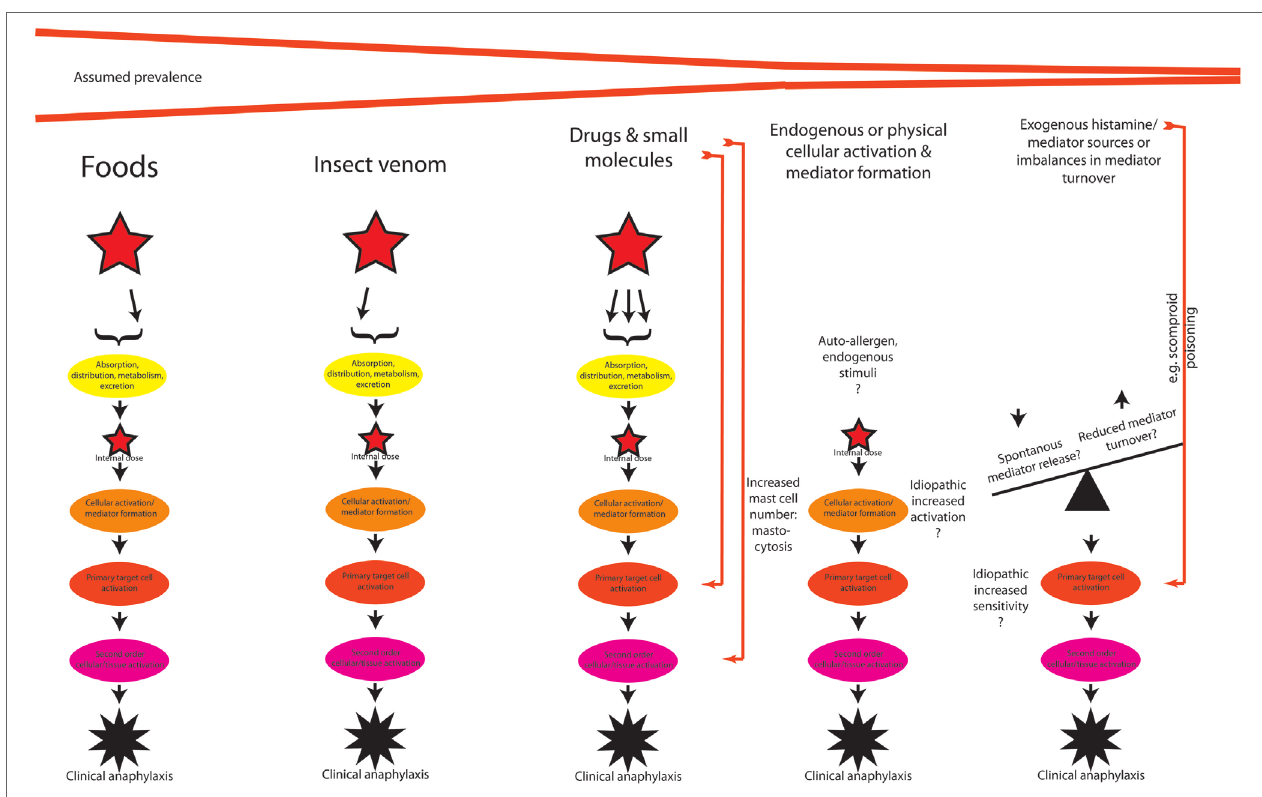
FiGURe 2 | A theoretical outline of the pathogenesis of anaphylaxis induced by different triggers, with potentially different pathways. See text for